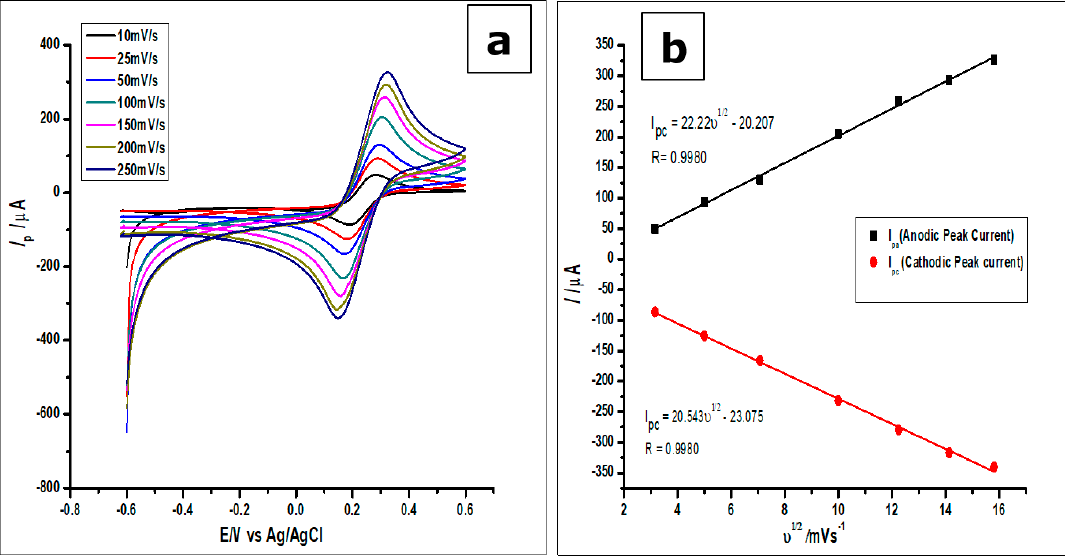
Figure 7. ( a ). Cyclic voltammograms of 1 mmol L − 1 [Fe(CN)6] 3 − / 4 + measured using the ZrO 2 nanoparticles modified CPE at increasing scan rates from 25–250 mVs − 1 ( b ). Plots of I p vs ν 1 / 2 , which would be used to calculate the true surface area.